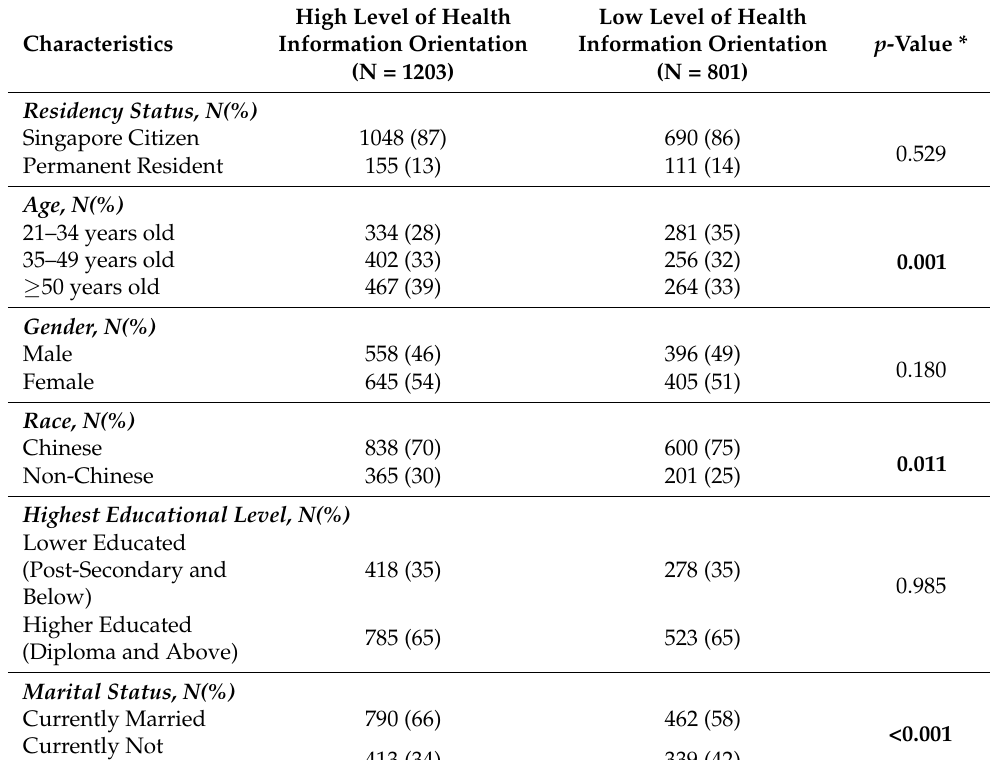
Table 2. Characteristics of 2004 respondents with high level of HIO vs. low level of